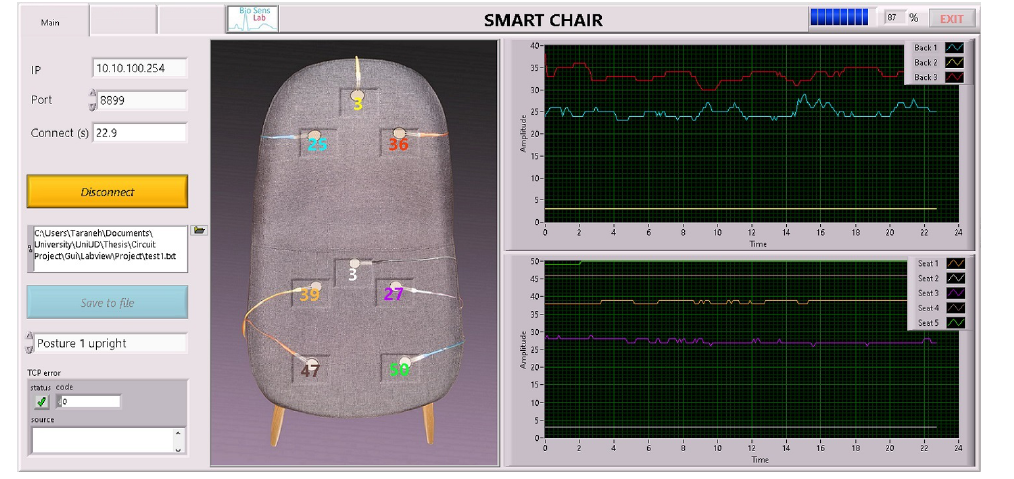
Figure 4. GUI front panel developed in LabVIEW™ environment for data acquisition and real-time plot. The sensor signals evolution in time are plotted on the graphs; the top and bottom graphs show the back and seat sensor signals, respectively. The real time sensor values are shown on a top view image of the chair in colored numbers. Controls are located on the left side of the front